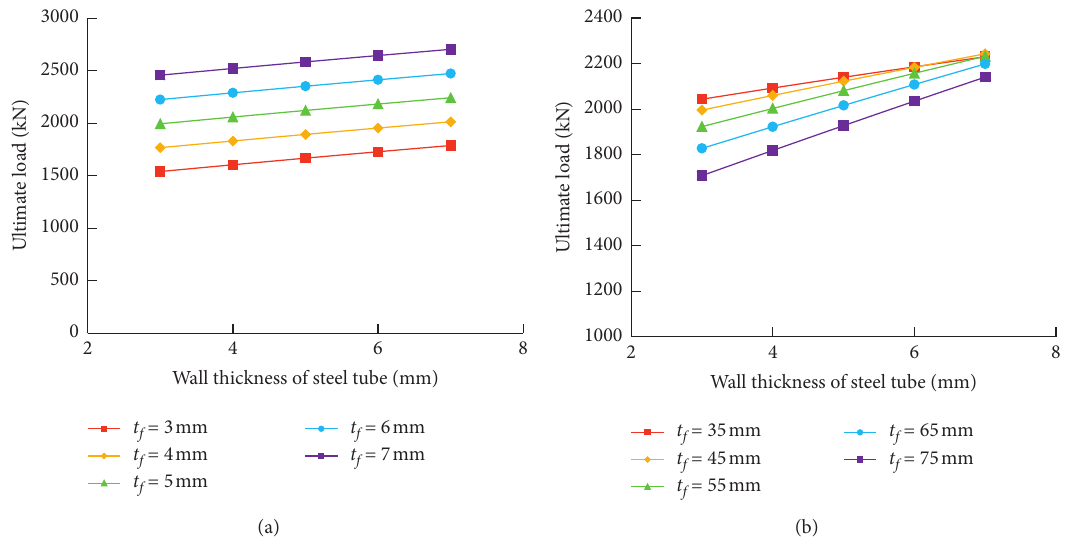
Figure 12: Influence of wall thickness of the steel tube on ultimate load.